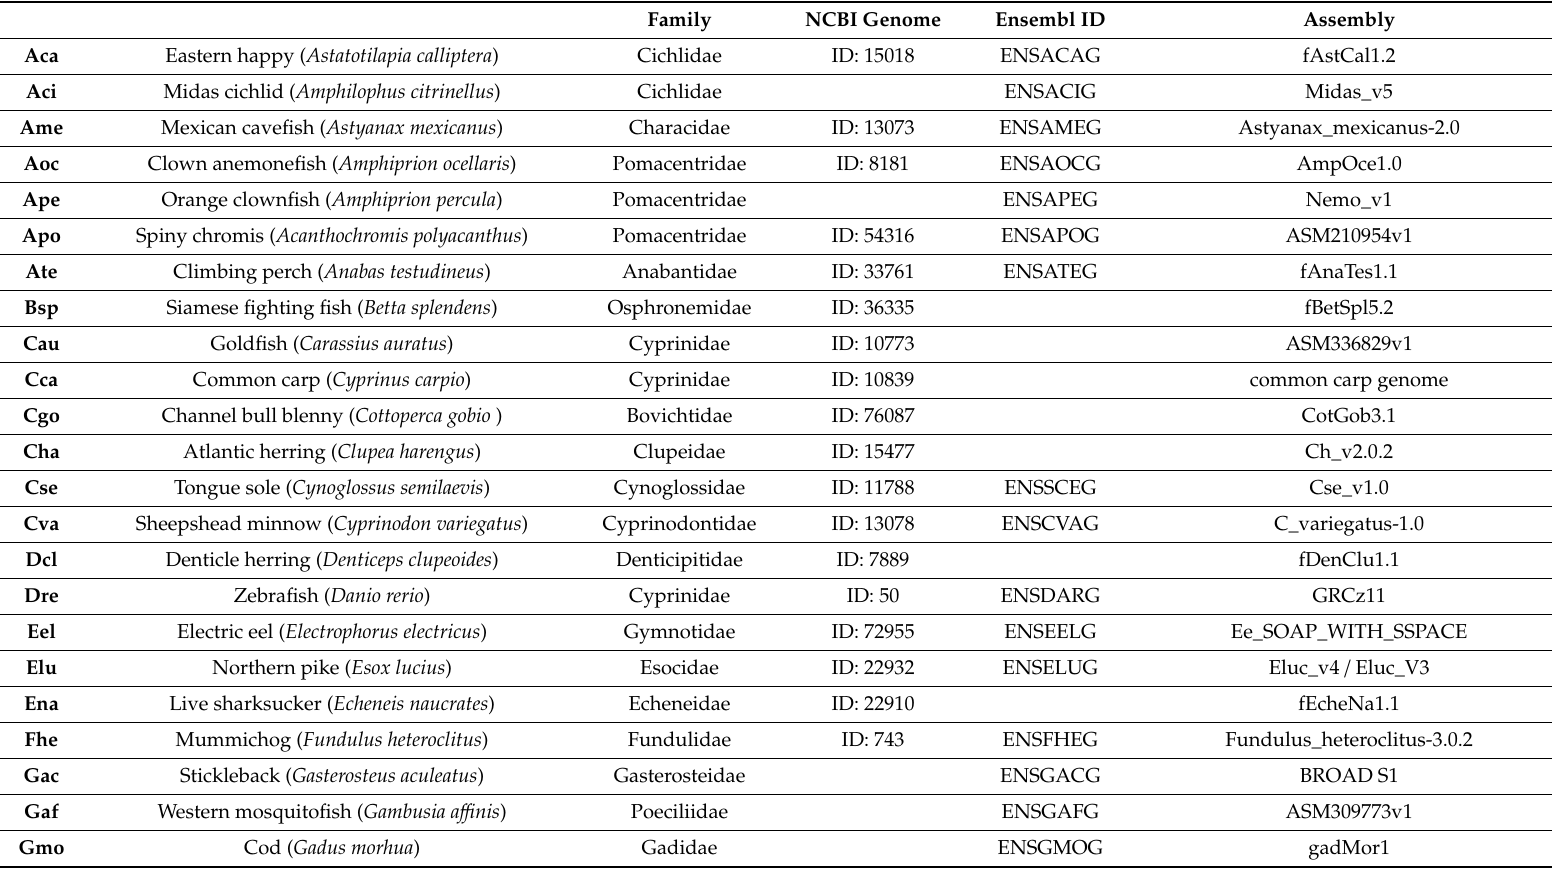
Table A1. List of the teleost